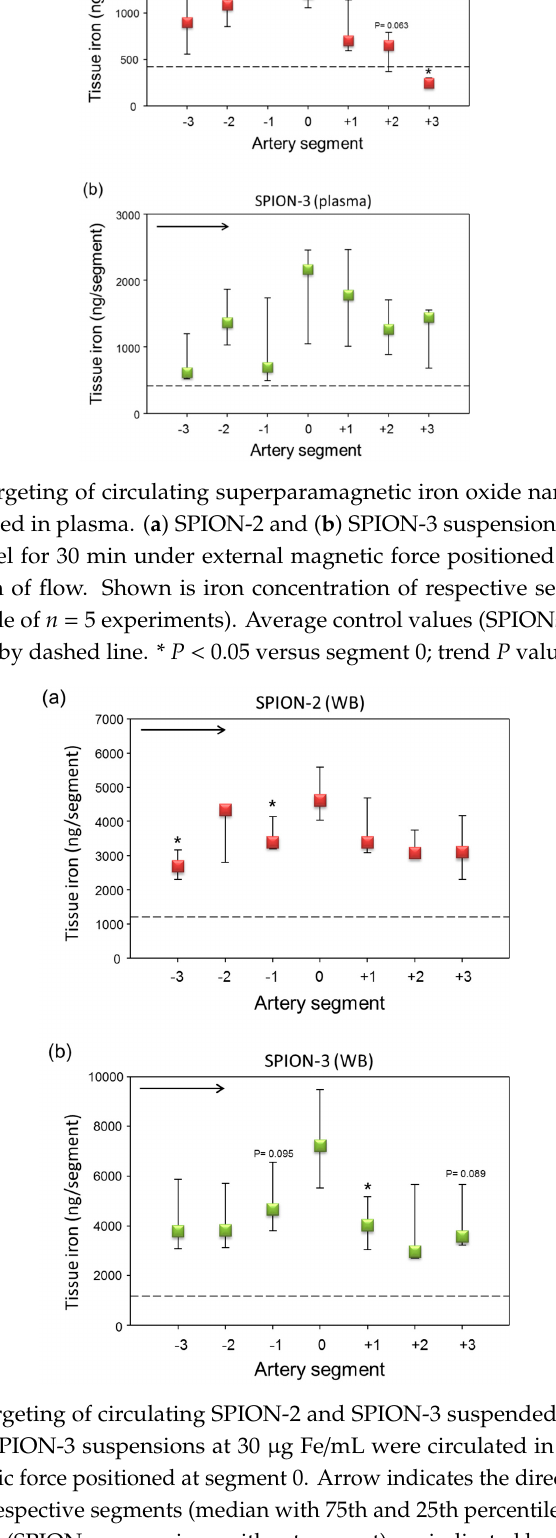
Figure 2. Magnetic targeting of circulating SPION-2 and SPION-3 suspended in whole blood (WB). ( a ) SPION-2 and ( b ) SPION-3 suspensions at 30 µ g Fe / mL were circulated in the model for 30 min under external magnetic force positioned at segment 0. Arrow indicates the direction of flow. Shown is iron concentration of respective segments (median with 75th and 25th percentile of n = 5 experiments). Average control values (SPIONs suspensions without magnet) are indicated by dashed line. * P < 0.05 versus segment 0; trend P values are indicated.